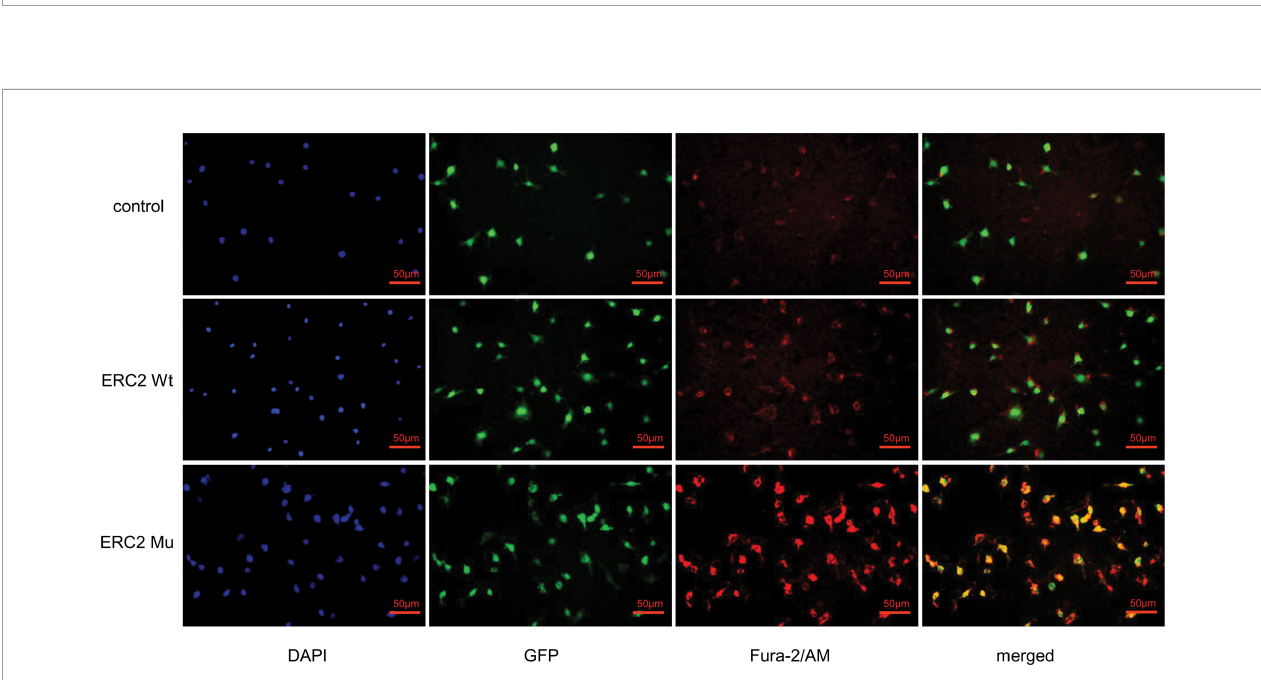
FIGURE 8 | ERC2 L309I mutation enhances endothelial intracellular calcium concentration. HUVECs were transduced with ERC2 wt and ERC2 mu (L309I) lentiviruses. HUVECs transduced with empty lentiviruses served as a control. Fura-2/AM was next applied to the cultures, and the intracellular free calcium concentration was then assessed for red fl uorescence after washing under a fl uorescence